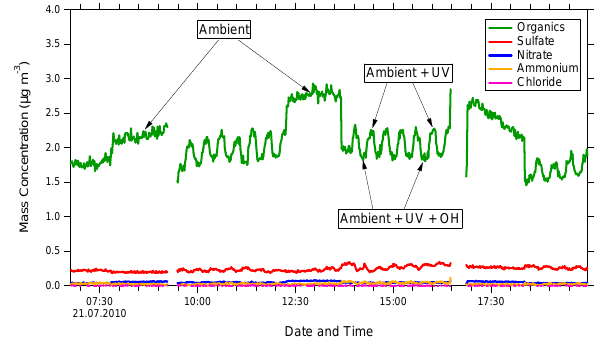
Fig. 2. Sample time series for TPOT AMS data, showing ambient, ambient+UV, and ambient+UV+OH